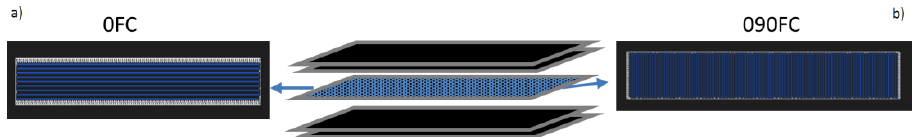
Figure 3. Scheme of fibre stacking sequences: ( a ) 0FC; ( b ) 090FC.